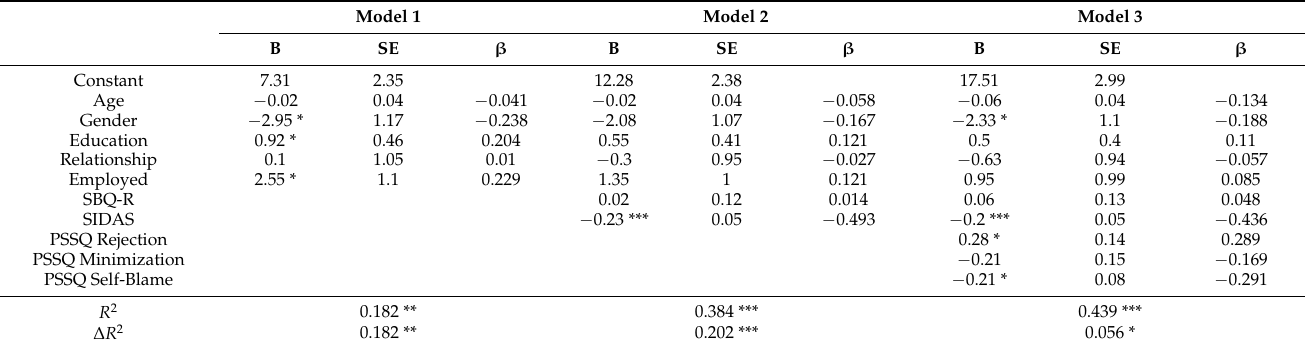
Table 3. Hierarchical regression analysis with well-being as the criterion (n =